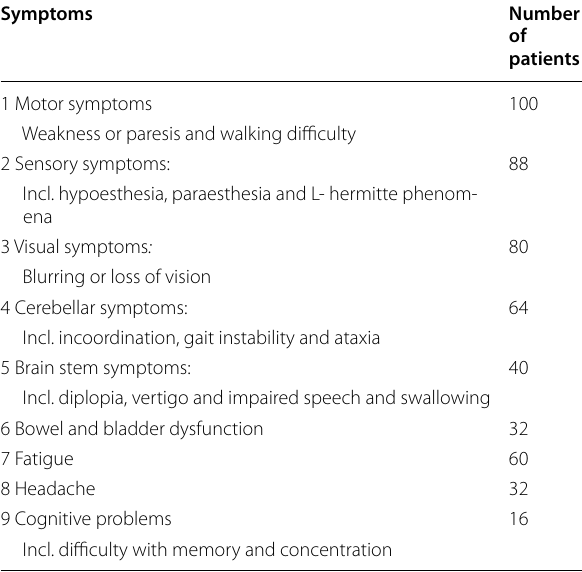
Table 4 Clinical symptoms of the studied patients. N.B: more than one symptom was present in the same patient Symptoms Number